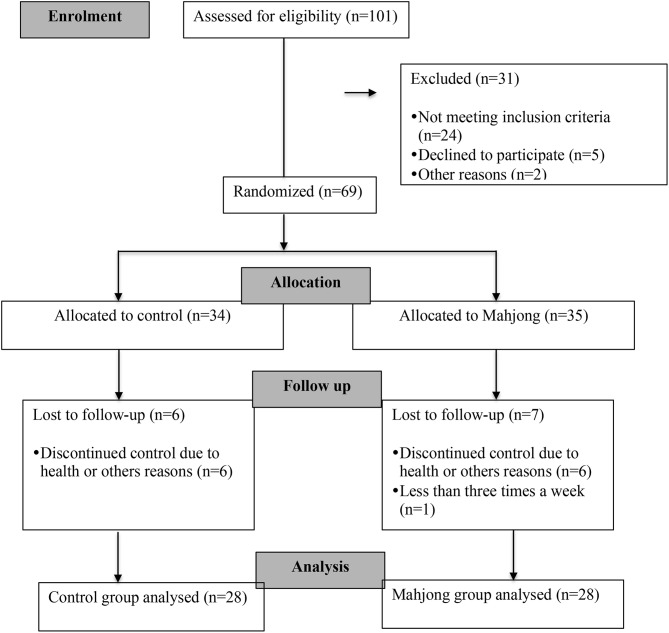
Flowchart of selection of subjects.